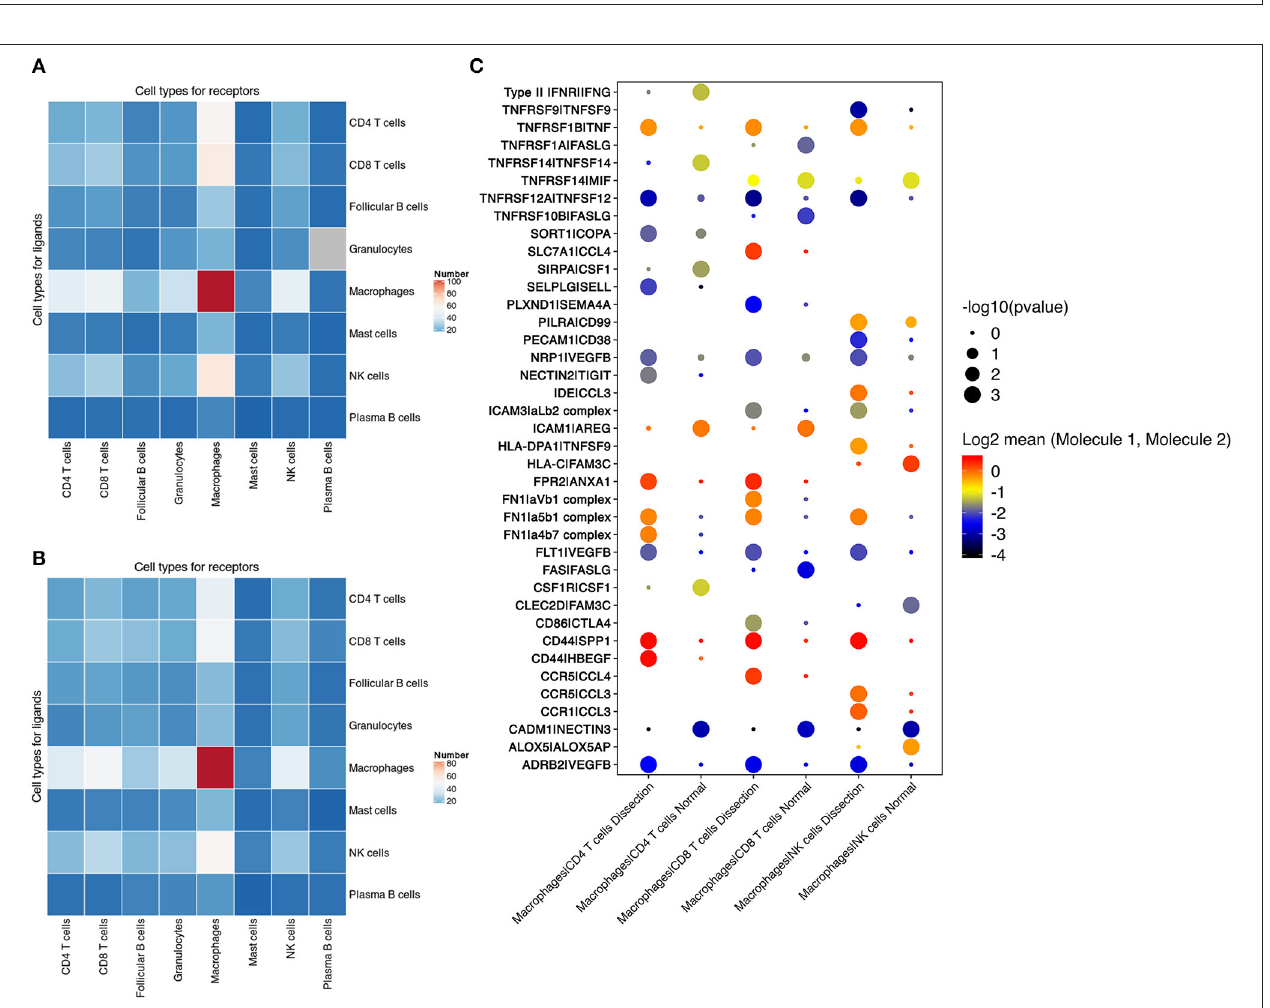
FIGURE 5 | clusters in the AD and NA groups. (F) SCENIC analysis of the top differentially expressed transcription factors among different clusters (left) or groups of B cells (right). FO B cells, follicular B cells; UMAP, uniform manifold approximation and projection for dimension reduction; SCENIC, single-cell regulatory network inference and clustering; AD, aortic dissection; NA, normal aorta.